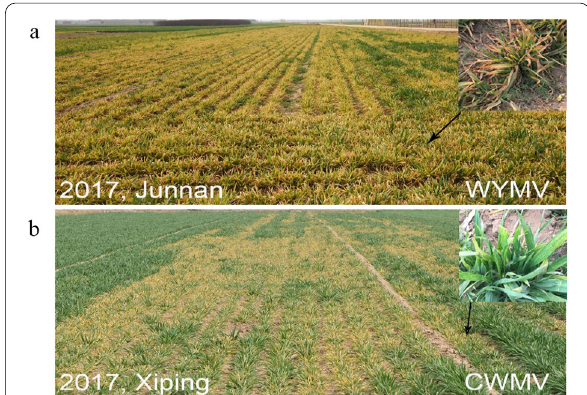
Fig. 1 Wheat plants showing lethal necrosis and mosaic. a The overall incidence of WYMV in a field in Junnan, Shandong Province. The small figure on the upper right shows an individual wheat plant infected with WYMV. b The overall incidence of CWMV in a field in Xiping, Henan Province. The small figure on the upper right shows an individual wheat plant infected with